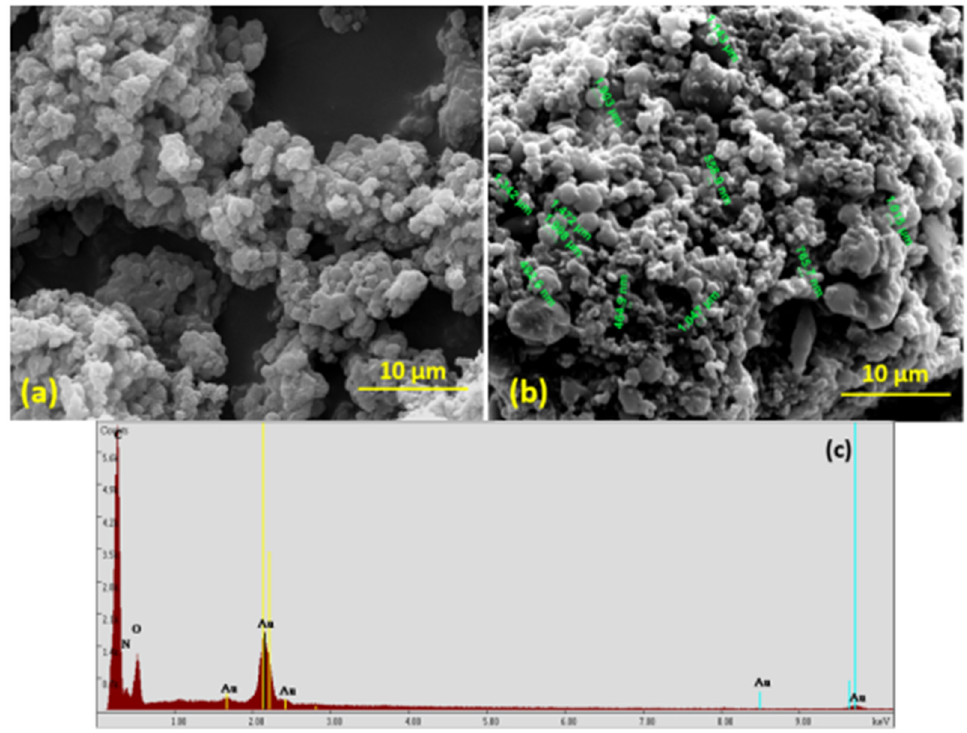
Figure 3. SEM images of ( a ) PANI and ( b ) PANI-N@CDs; ( c ) SEM-EDX of PANI-N@CDs.